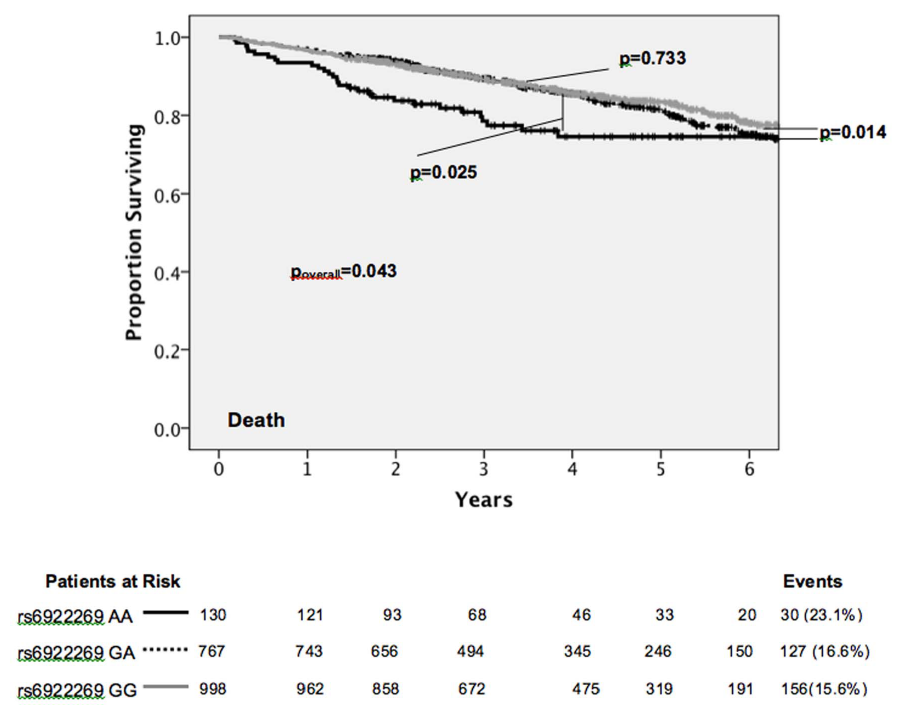
Figure 2. Kaplan-Meier survival analysis of CDCS cohort patients stratified by rs6922269 genotype.